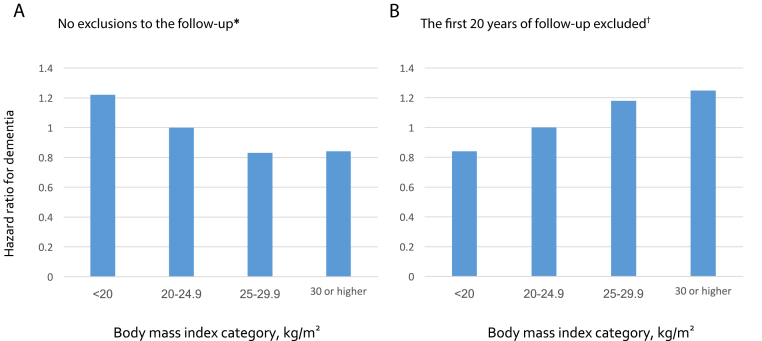
Shape of the association between BMI and dementia before (A) and after (B) exclusion of the first 20 years of follow-up. ∗39 studies, total N = 1,349,857. †10 studies, total N = 391,596. The figure shows that risk of bias due to preclinical dementia is smaller after exclusion of follow-up.